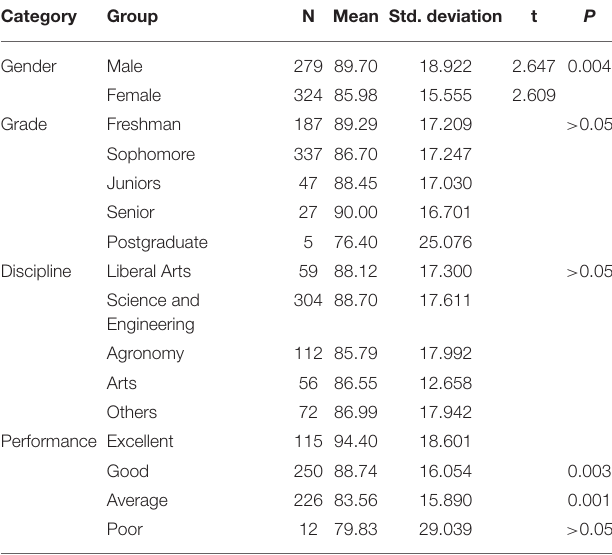
TABLE 2 | The psychological resilience scores of